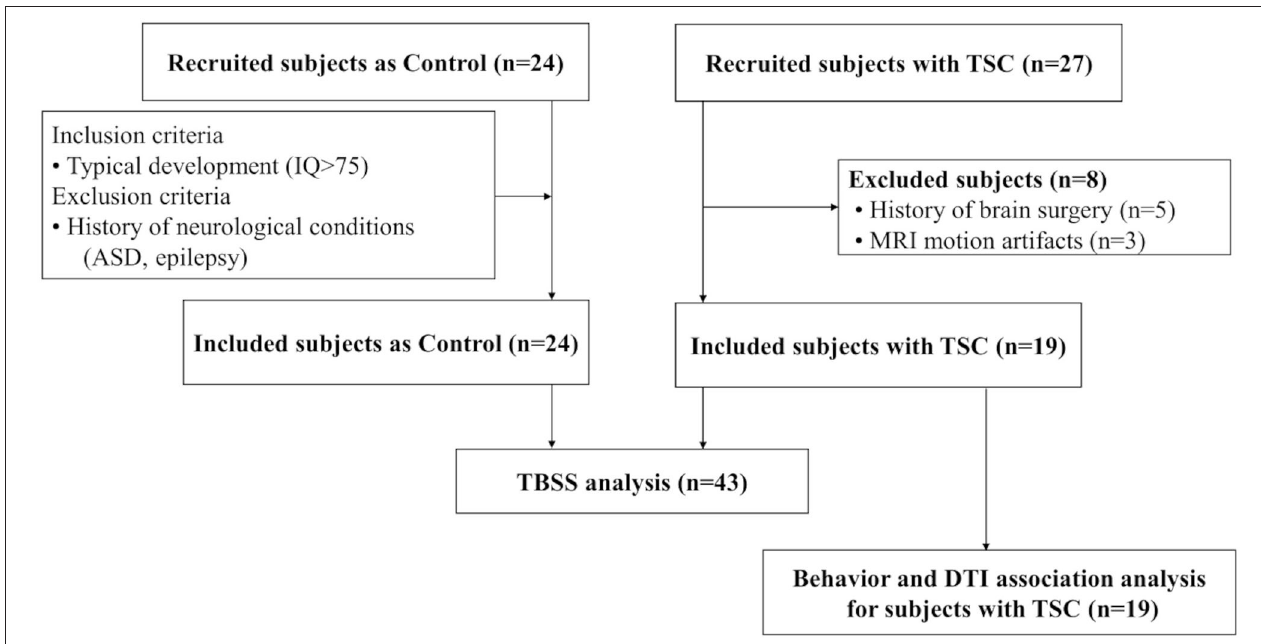
FIGURE 1 | A total of 19 subjects with TSC and 24 age-matched controls are enrolled. To compare the white matter microstructural integrity between the TSC and control groups, tract-based spatial statistics (TBSS) are performed. Next, to reveal TAND-related white matter, association analysis is performed between behavior assessments and DTI parameters (FA/MD) for subjects with TSC ( n = 19).